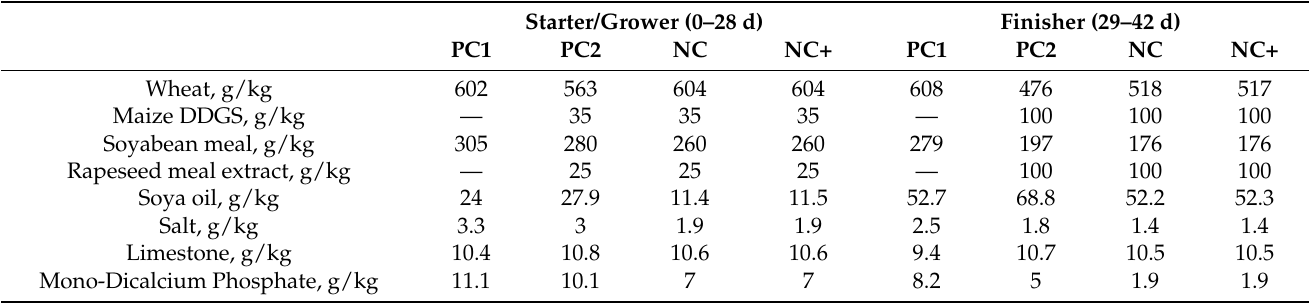
Table 1. Formulated composition of experimental